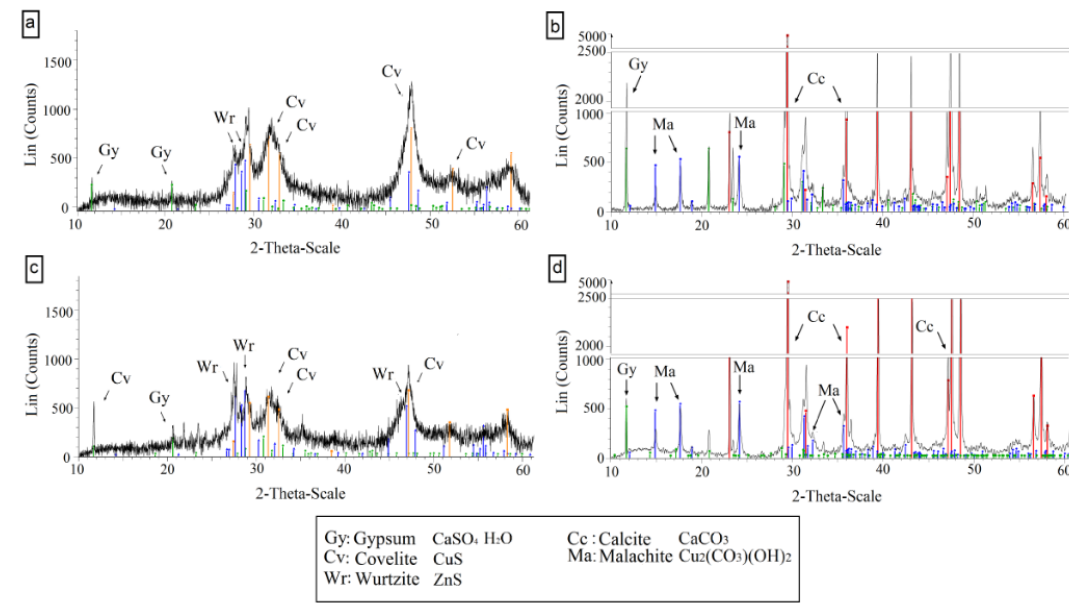
Figure 9. Diffractograms of precipitates sampled from the inside of reactors: ( a ) A-SDES; ( b ) B-SDES; ( c ) C-DAS; ( d ) D-ADES.